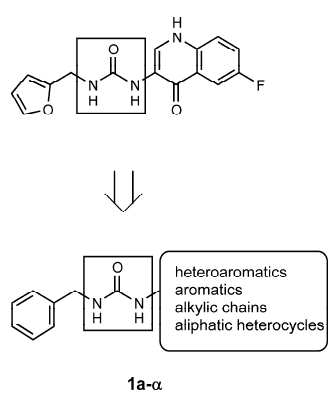
Figure 2. Structural modifications performed on Hit 2 .